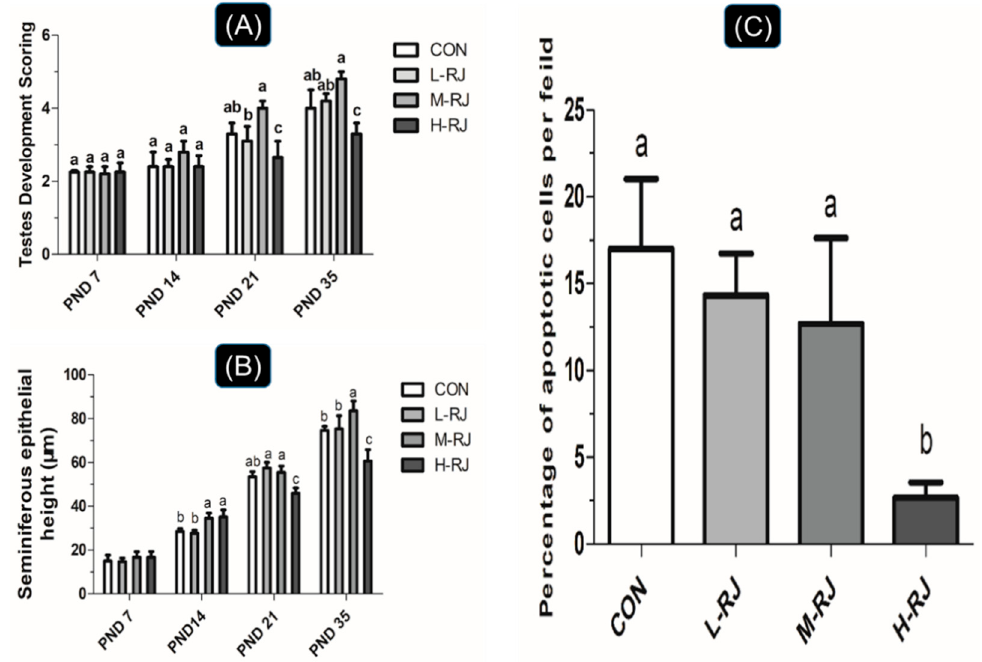
Figure 2. The data in graph represent testis scoring results and data shown as mean ± SE (n = 100) and different letters (A, B, C) within a column represent significantly ( p < 0.05) differences among the groups.